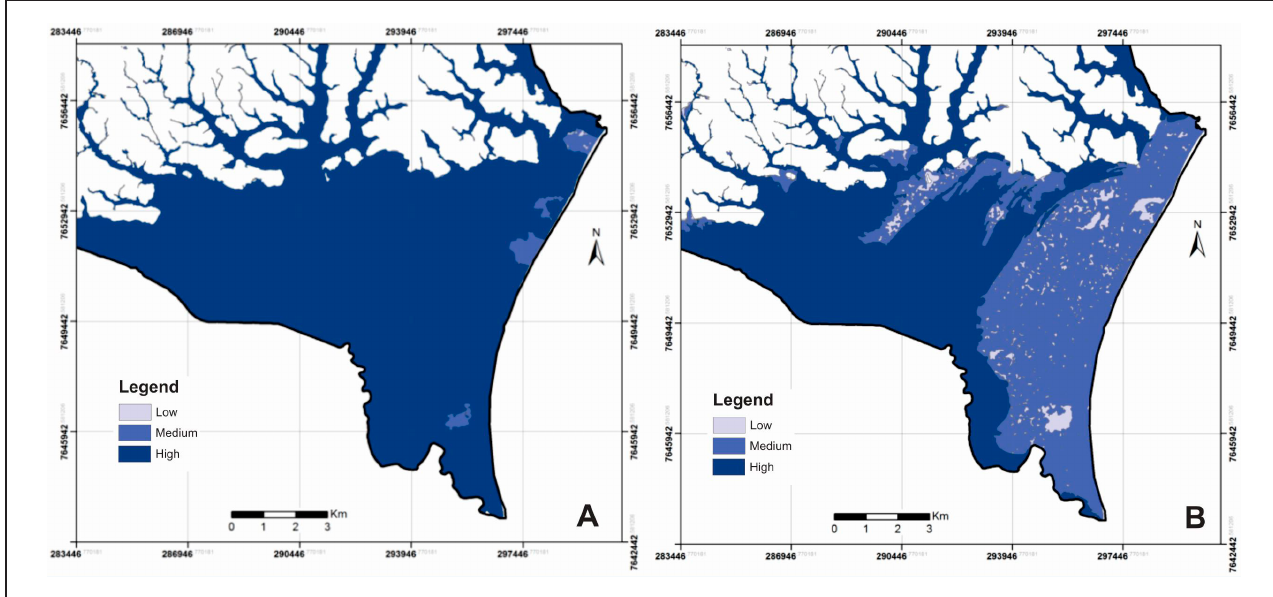
Figure 9 - Modeling detail of the southeast region of Presidente Kennedy/ES. (A) Modeling using the previous methodology (Hand + morphometric information of the hydrographic basins); (B) Flood modeling using the methodology that replaces hydrographic basin information with the flood susceptibility of relief patterns.